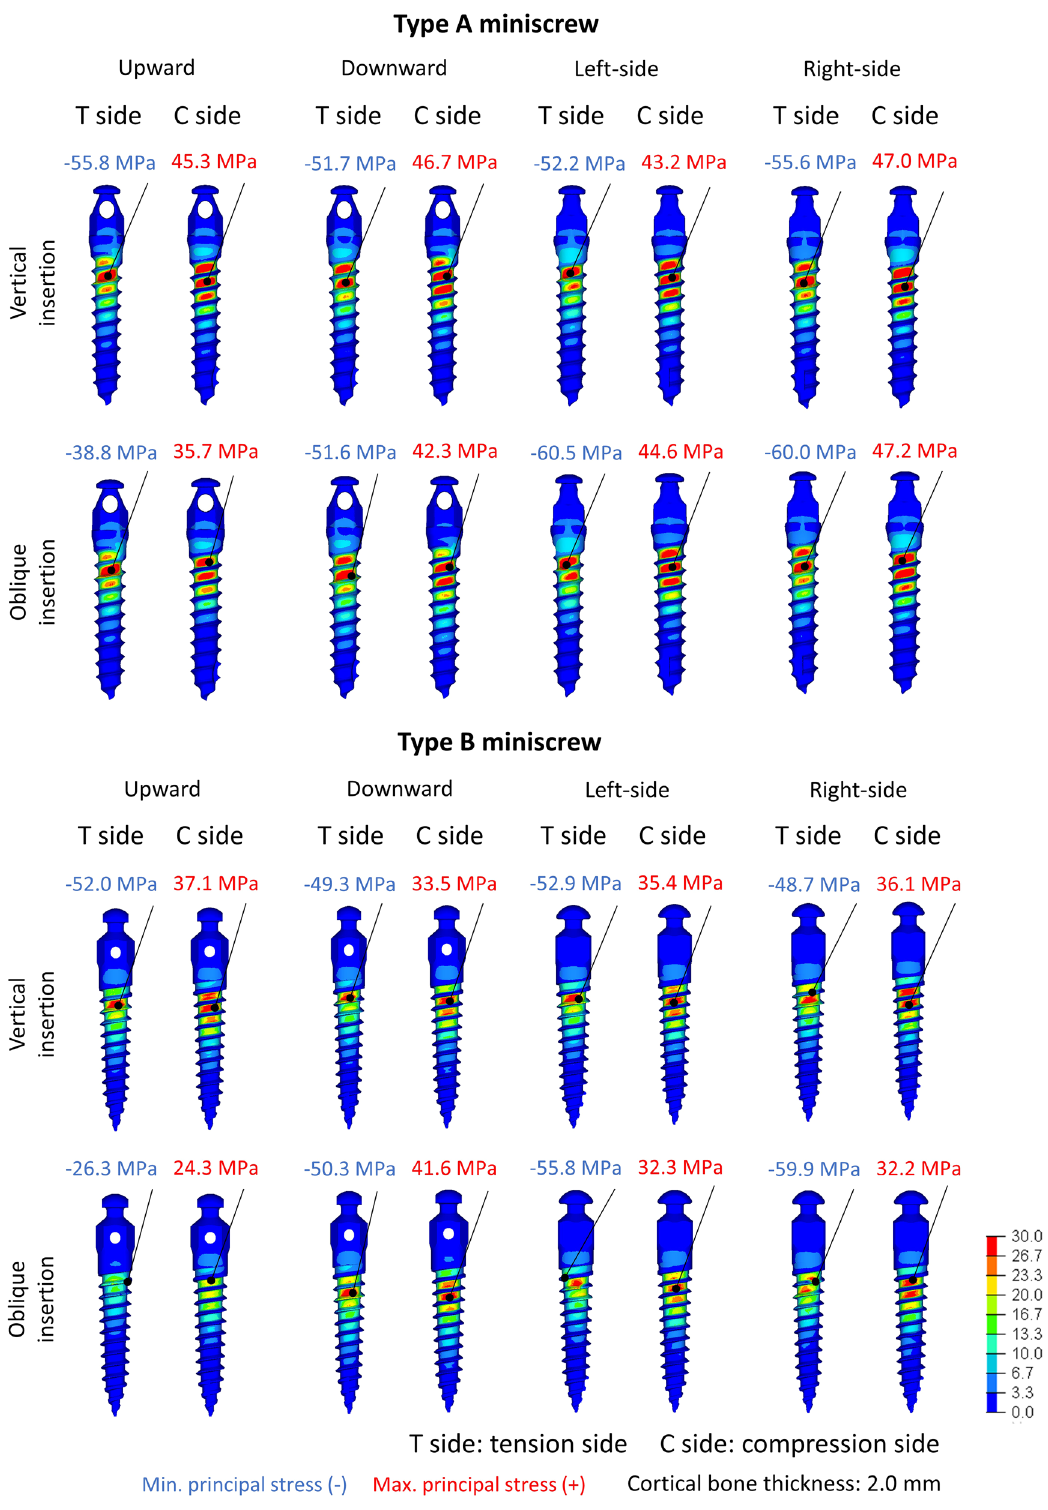
Figure 3. Distribution of maximum and minimum principal stresses on the miniscrew surface on the loaded side when the miniscrew was placed vertically or obliquely in a model of 2.0 mm thick cortical